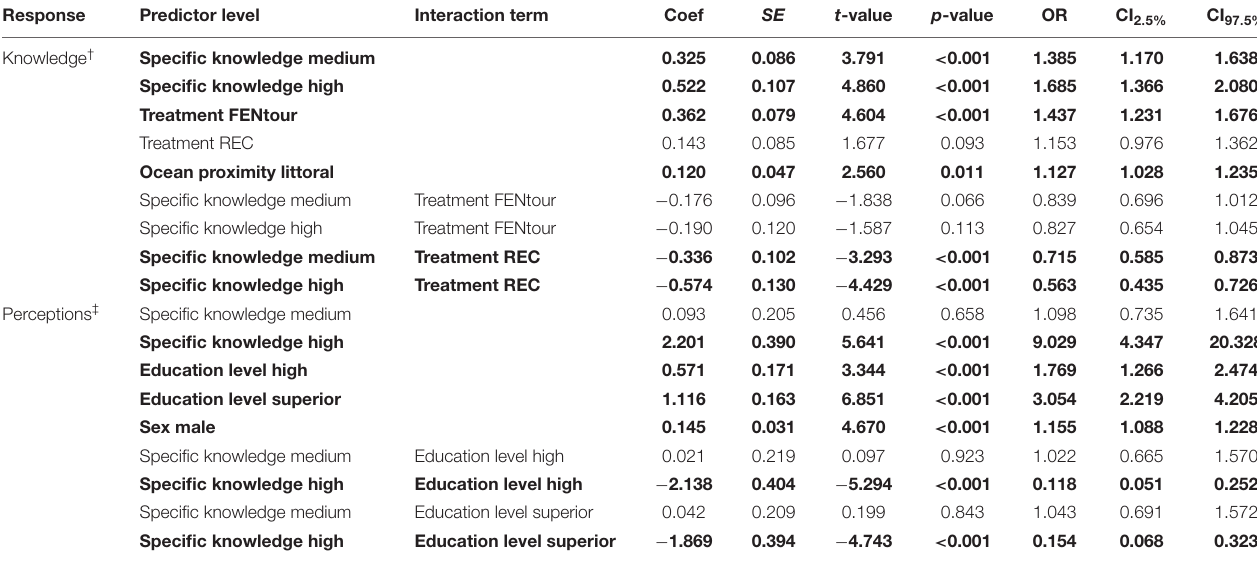
TABLE 3 | Ordinal logistic regression model results for the effects of multiple predictor variables on public knowledge about and perceptions toward sharks assessed with Likert questions.